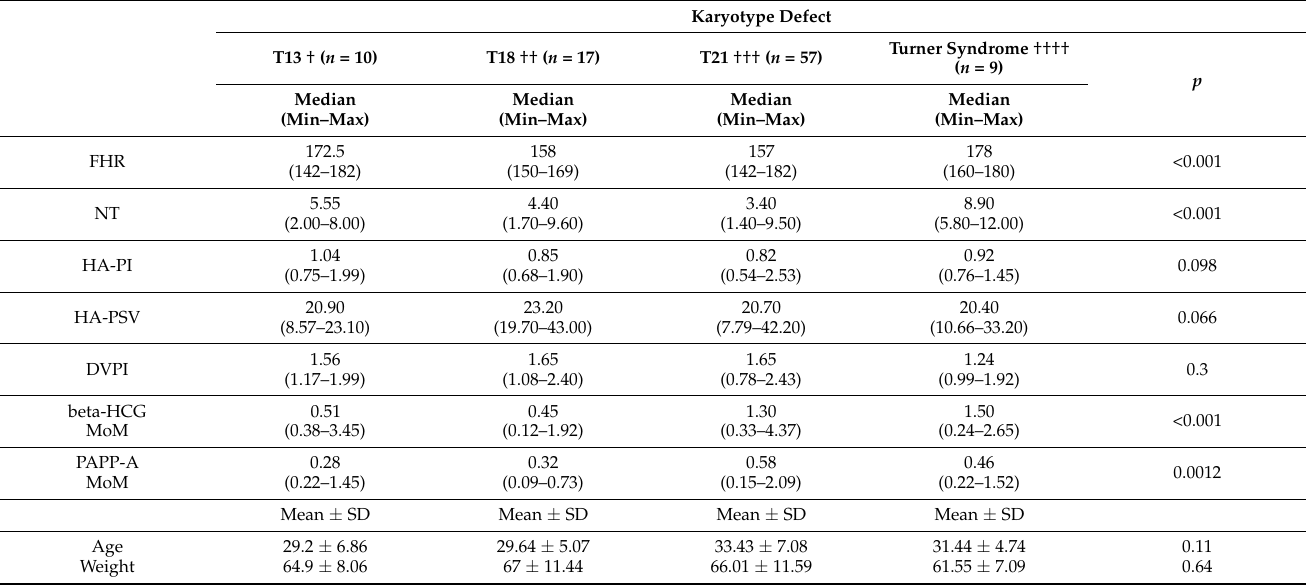
Table 4. Differences between selected first-trimester screening parameters depending on the type of aneuploidy.